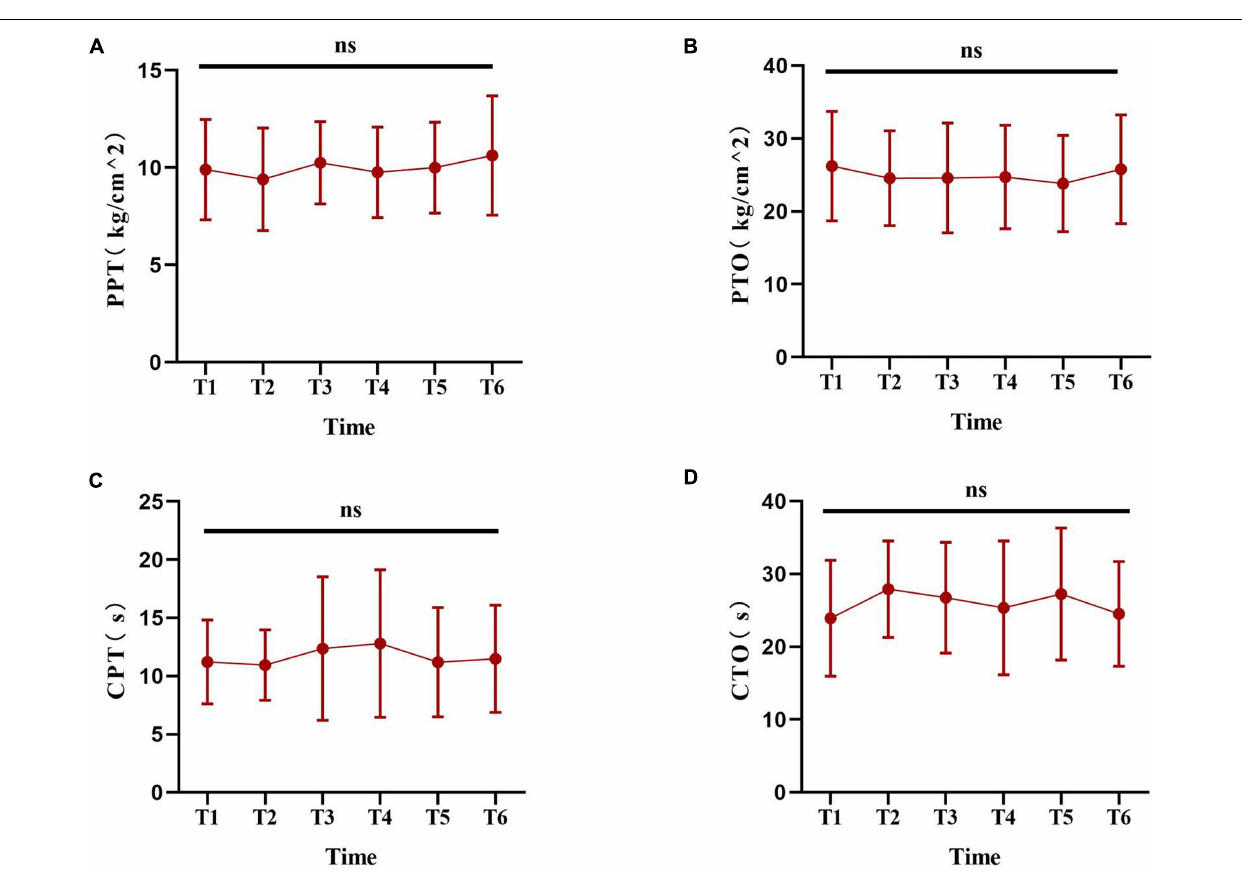
FIGURE 2 | The pilot experiment based on laboratory members. (A–D) Show the change trend of the experimental pain thresholds (including PPT, PTO, CPT and CTO) at the six time points. Data are presented as mean ± standard deviation. PPT, pressure pain threshold; PTO, pressure pain tolerance; CPT, cold pain threshold; CTO, cold pain